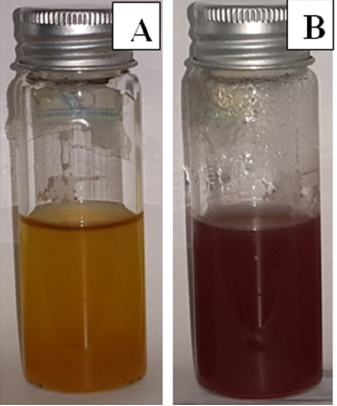
Figure 2: Illustration of colour change in mixed Aloe vera leaf extract and Na SeO solution: (a) before synthesis, (b) after 2 3 synthesis using autoclave.